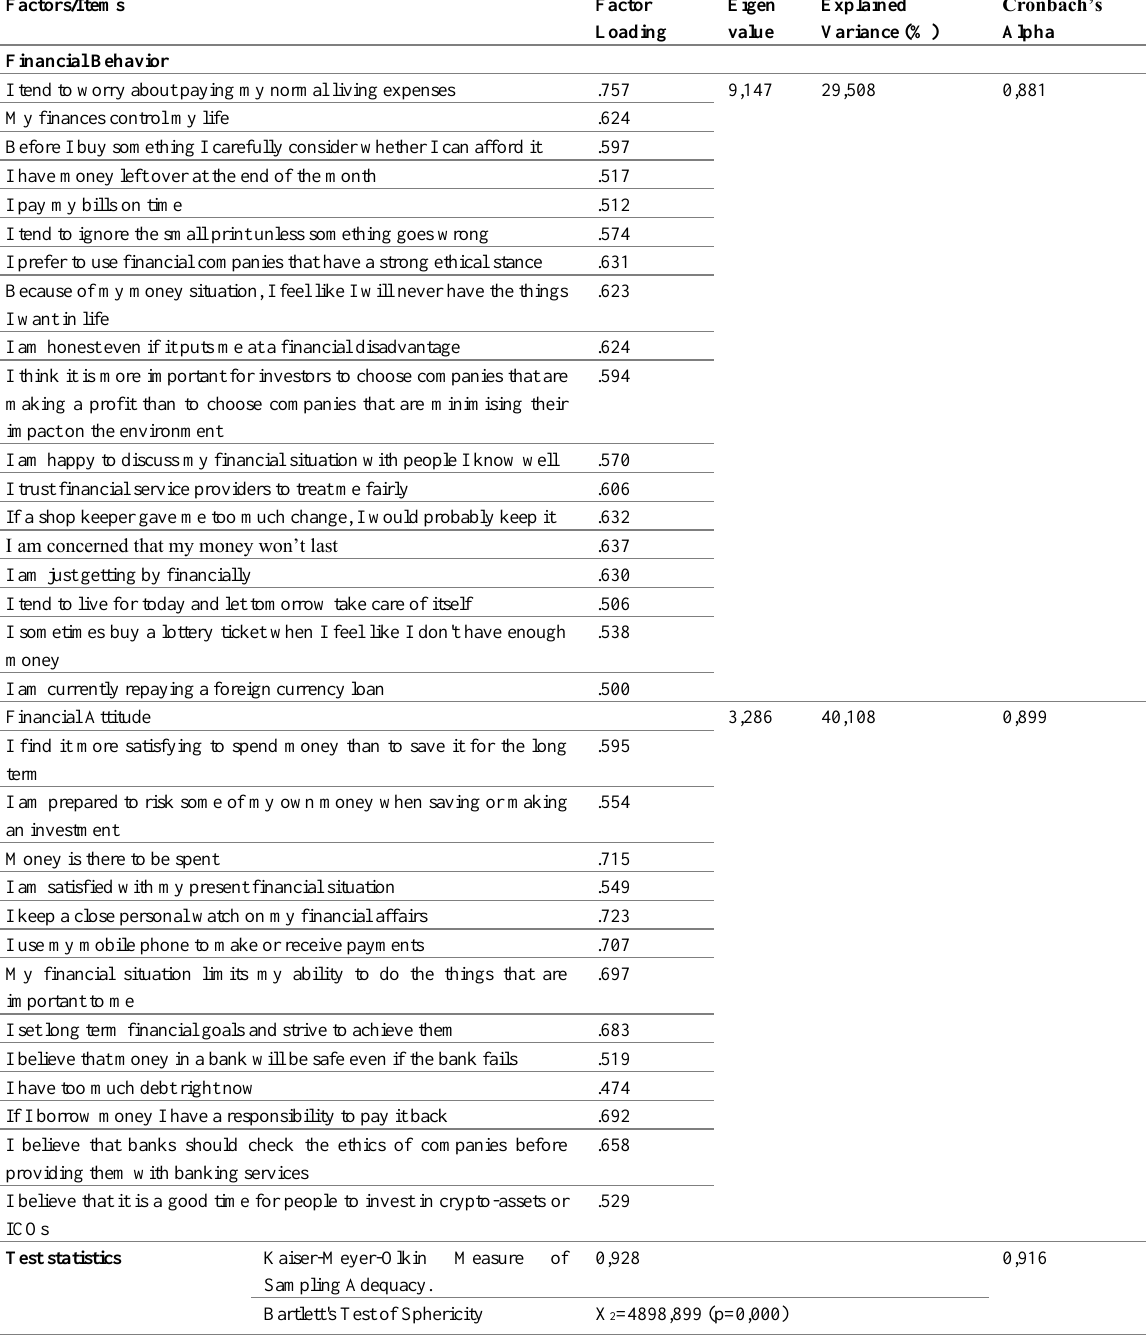
Table 1: EFA results and Cronbach’s α values for the factors financial behavior and financial attitudes